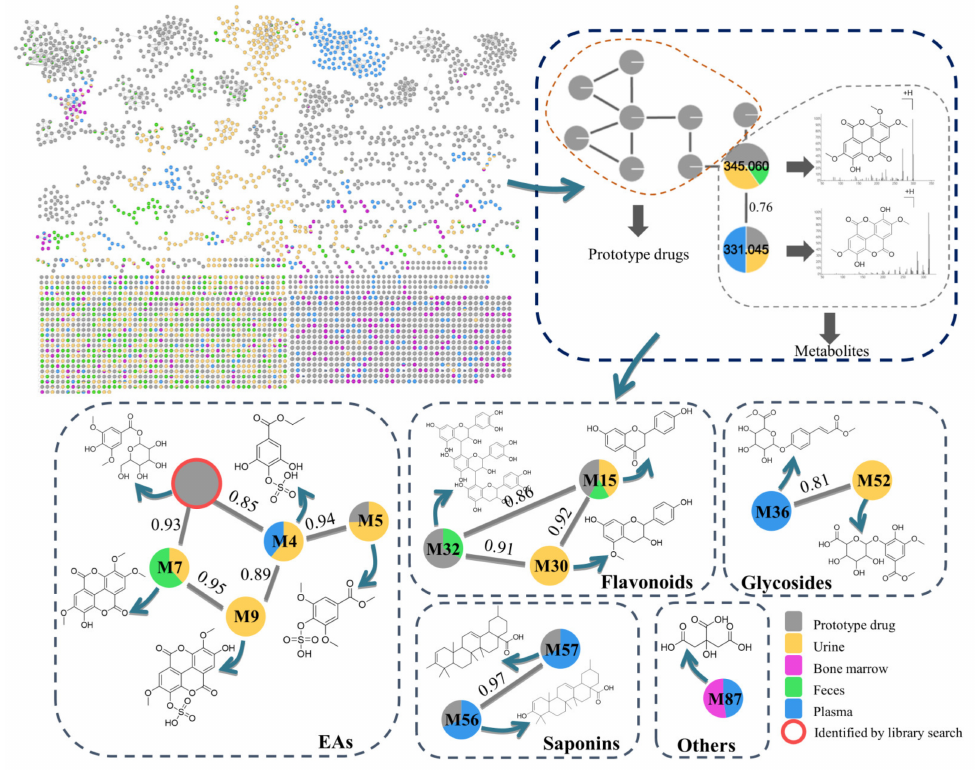
Figure 1. Metabolites molecular networks of SO